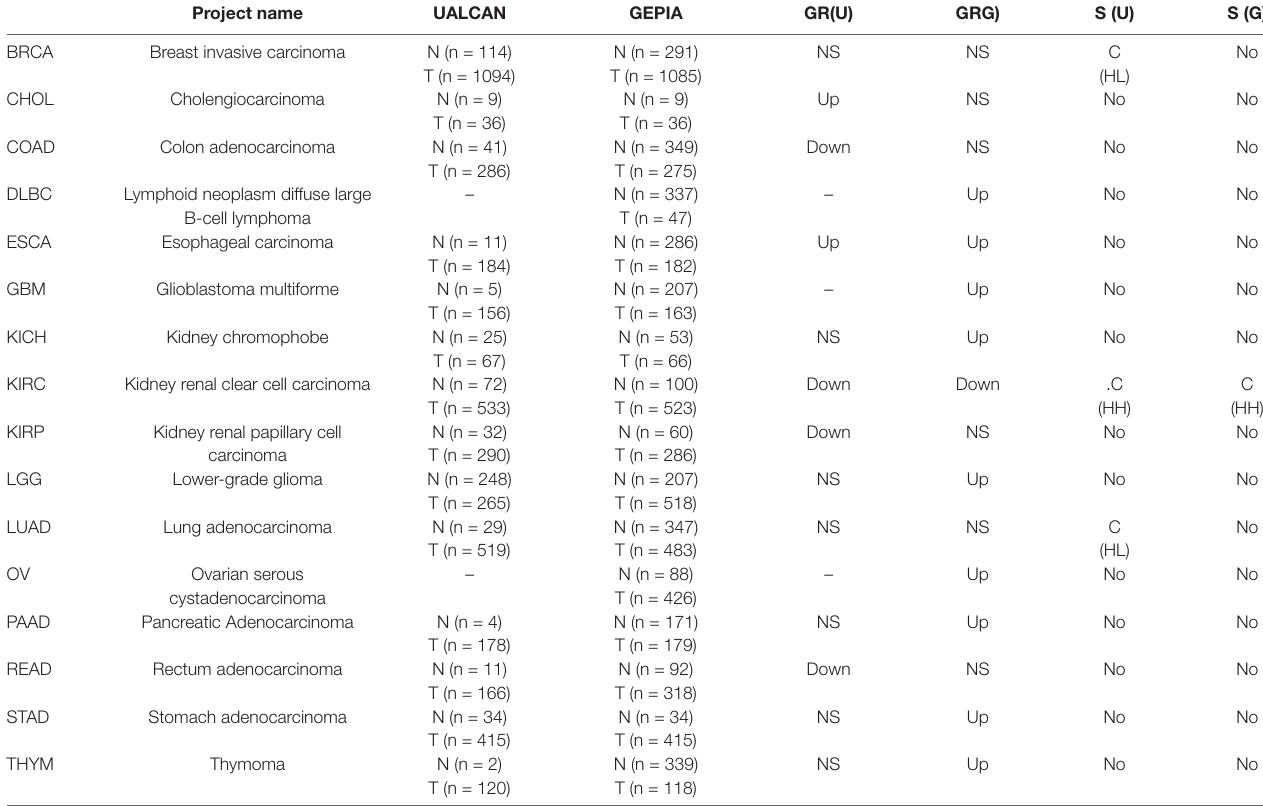
TABLE 1 | Differential MuD expression and survival correlation revealed by UALCAN and